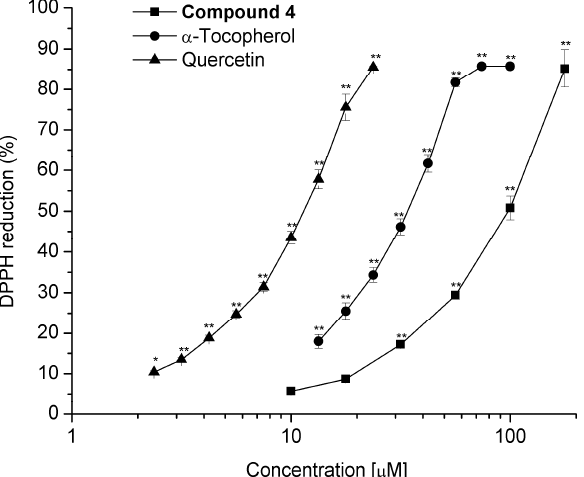
Figure 9. Dose-response curve for determining the IC 50 value for scavenging activity on free radical 2,2-diphenil-1-picrylhydrazyl (DPPH) of compound 4 compared with standards α -tocopherol and